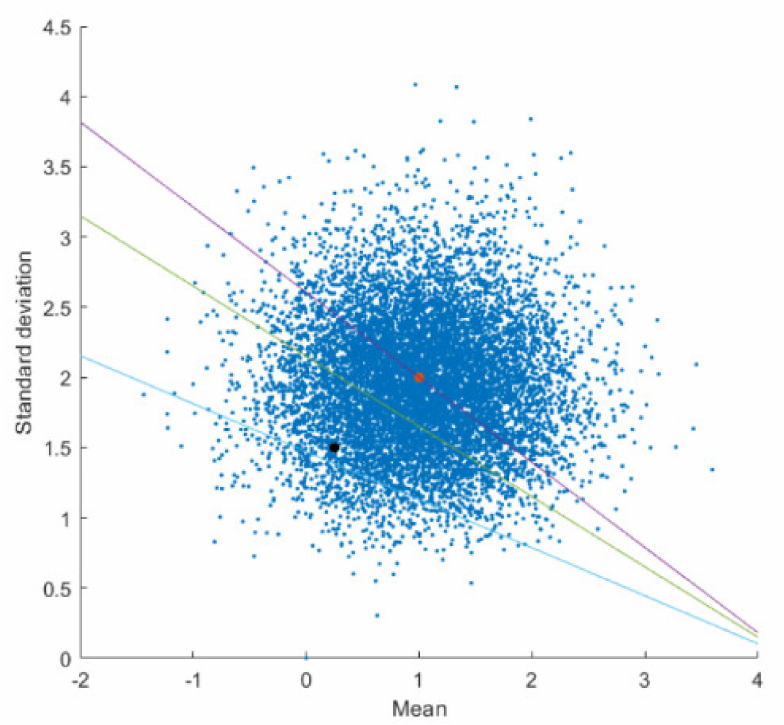
Figure A7. Joint distribution of mean values and standard